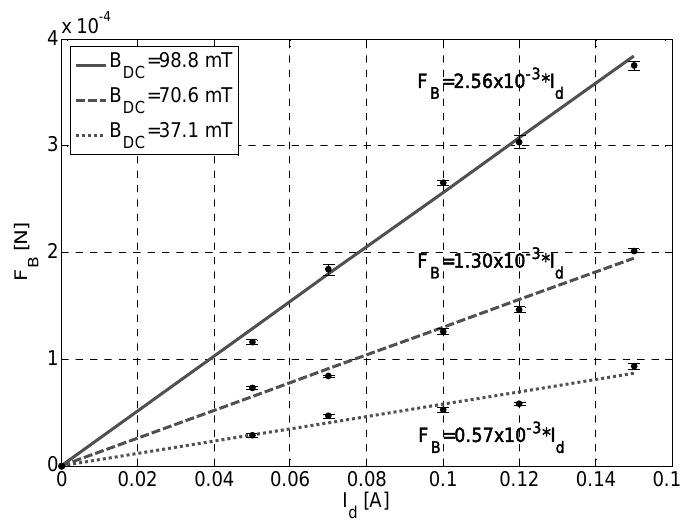
Figure 5. The measured force F B as a function of I d for different values of B DC .